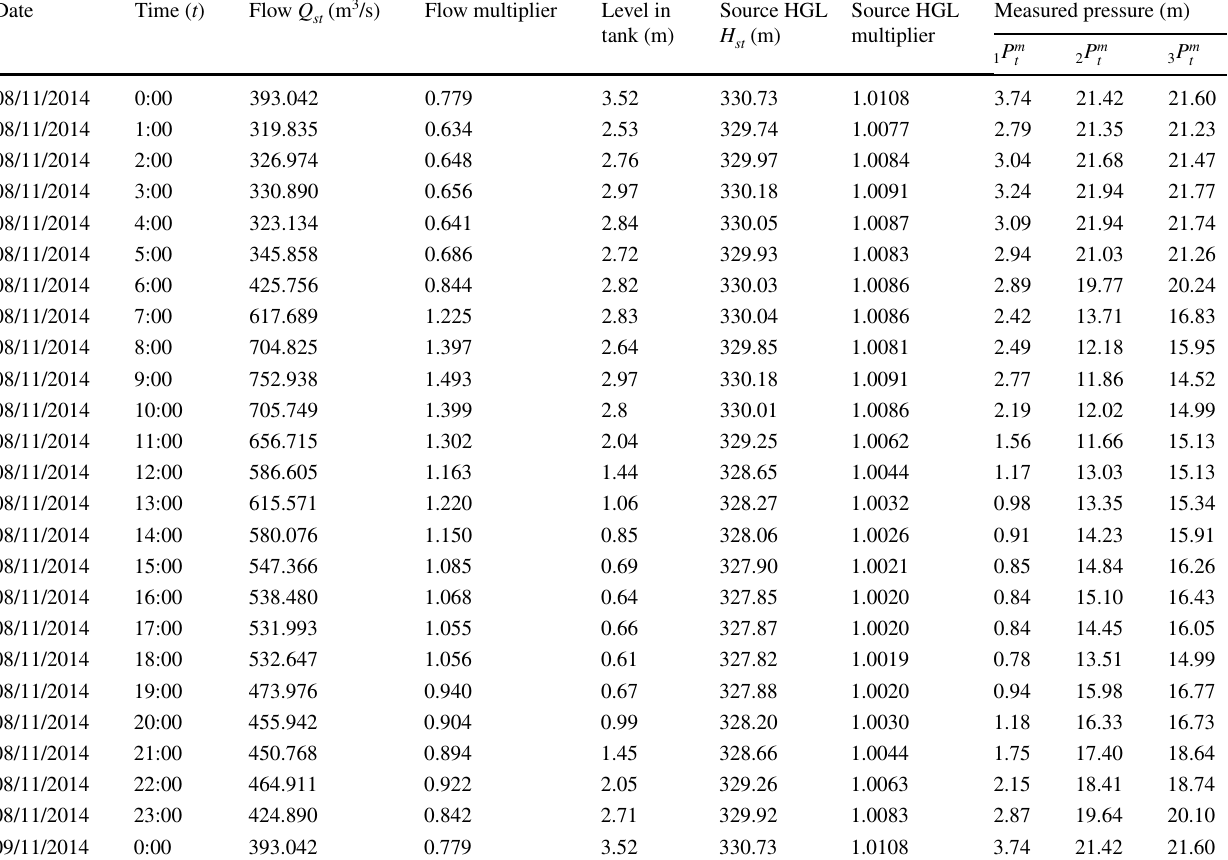
Table 1 Flow from GSR and observation of the level in the tank and pressures at selected observation points on